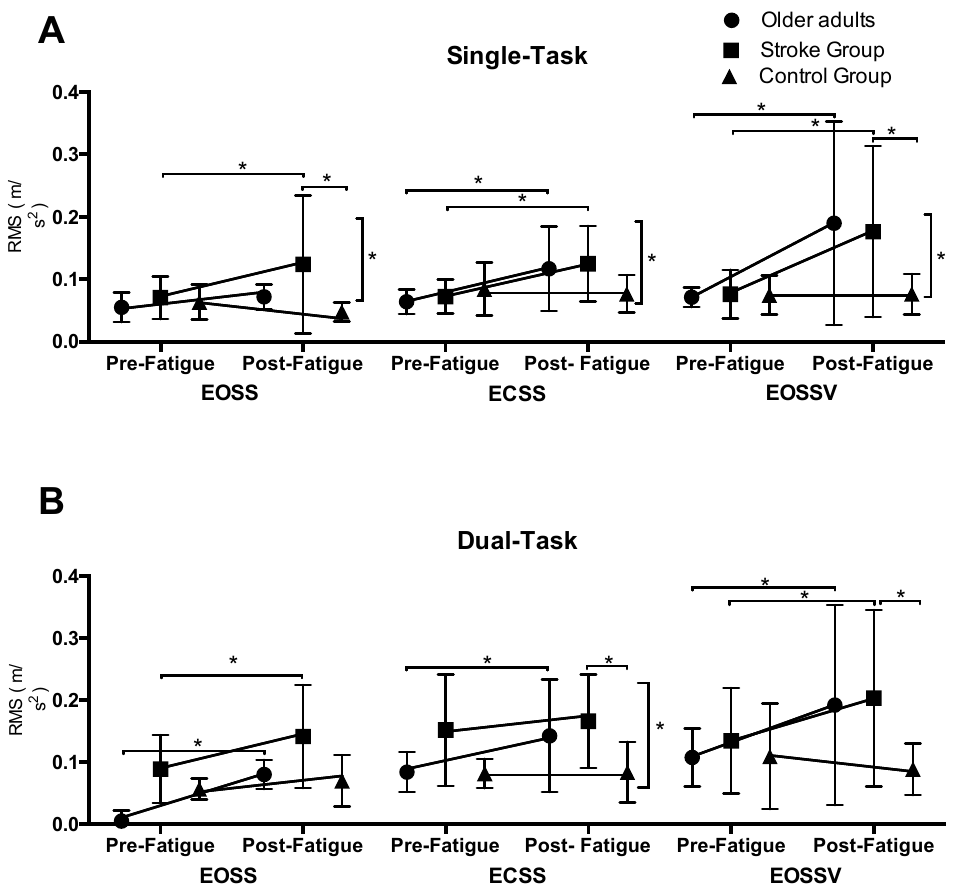
Figure 4. Shows the root mean square (RMS) of COM values in each SOT condition for the older adults, stroke, and control groups recorded before and after the mental fatigue and control intervention, respectively, during the ( A ). Single-task protocol; ( B ). Dual-task protocol. * p < 0.05. Vertical bars represent the time by group effect. Data are presented as the mean ± standard deviation.